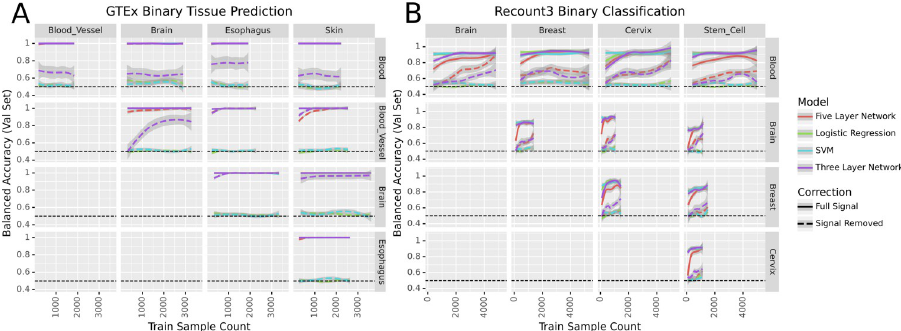
Fig 2. Models’ performance across binary classification tasks before and after signal removal in the Recount and GTEx datasets.